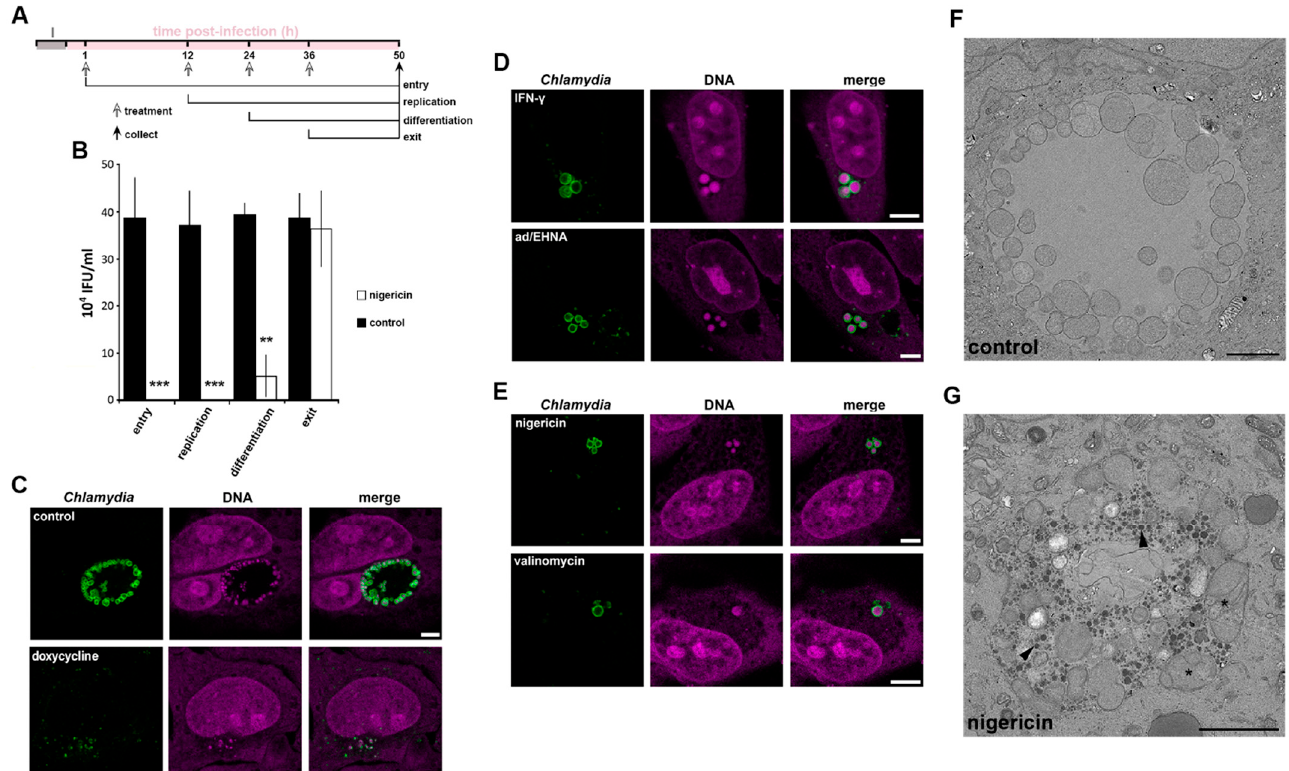
Figure 3. Effect of K + ionophores on chlamydial infectivity and morphology. HeLa cells were infected with C. trachomatis LGV2. ( A ) Schematic of the experiment design associated with panel B. I: infection. Time of treatment, corresponding to the different phases of the Chlamydia lifecycle as indicated, and collection have been determined based on the titration assay (Figure 2D). ( B ) Infected cells were treated with nigericin (white bars) or untreated (black bars) at the indicated phase of the lifecycle ( x -axis) and samples collected at 50 hpi. Infectivity was assessed and IFU/mL indicated on the y -axis. ** p < 0.01, *** p < 0.005. Error bars: standard deviation. For ( C – E ) cells were treated as indicated at 12 hpi and fixed at 24 hpi prior to labelling with anti- Chlamydia (green) and DNA probe (magenta). Scale bar: 5 µm. ( C ) upper panels: non-treated, lower panels: doxycycline ( D ) upper panels: IFN- γ lower panels: adenosine (Ad/EHNA) ( E ) upper panels: nigericin, lower panels: valinomycin. ( F , G ) control infected cells ( F ) or treated at 12 hpi with nigericin ( G ) prior to processing for transmission electron microscopy at 24 hpi. Scale bar: 2 µm.